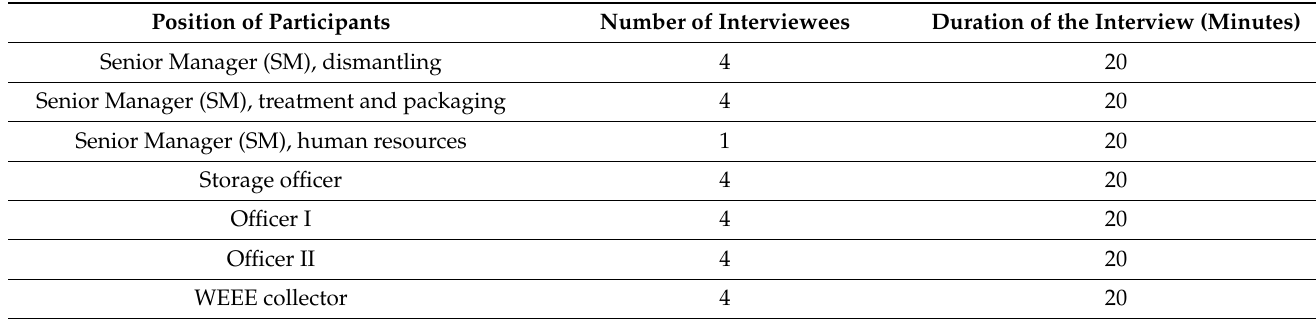
Table 1. Interviewee basic